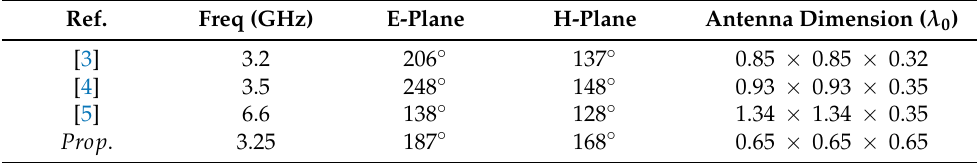
Table 4. Comparison between recent works of wide-beamwidth DRA.